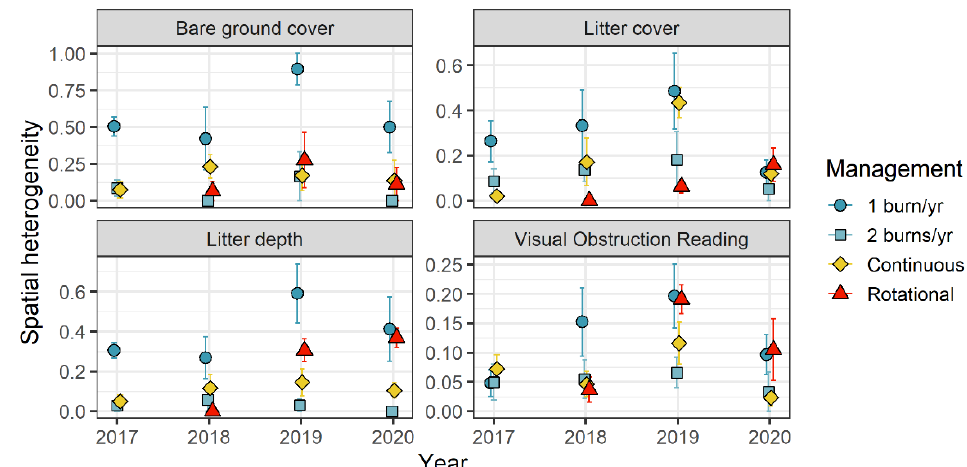
Figure 7. Spatial heterogeneity of vegetation structure over time under four grazing regimes at the Central Grasslands Research Extension Center in Streeter, ND. Error bars represent one standard error.